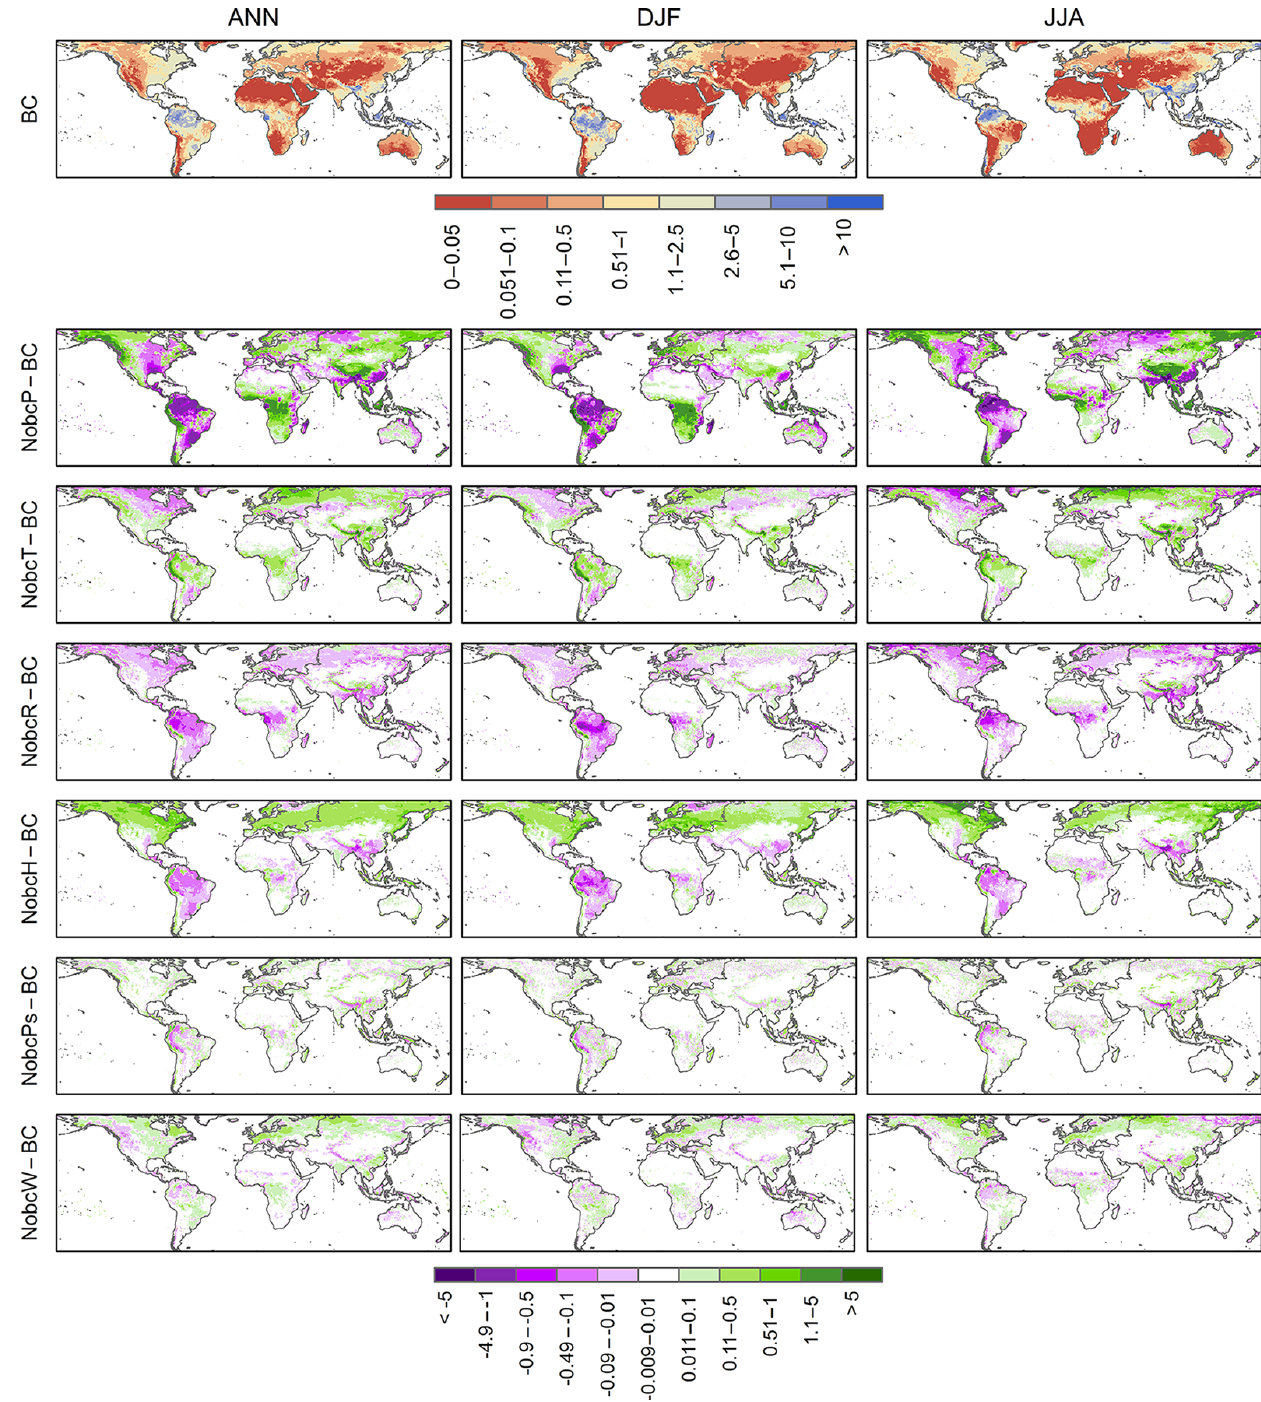
Figure 8. (Top row) Runoff (mmday − 1 ) from bias corrected GCM ensemble forcing (BC) and (second to last row) runoff differences between the bias corrected run (BC) and the partially corrected runs (NobcV, where V is one of the forcing variables P , T , R , H , Ps, or W ). Results are shown for long-term annual averages (ANN) and for December–January–February (DJF) and June–July–August (JJA) averages of the 1981–2010